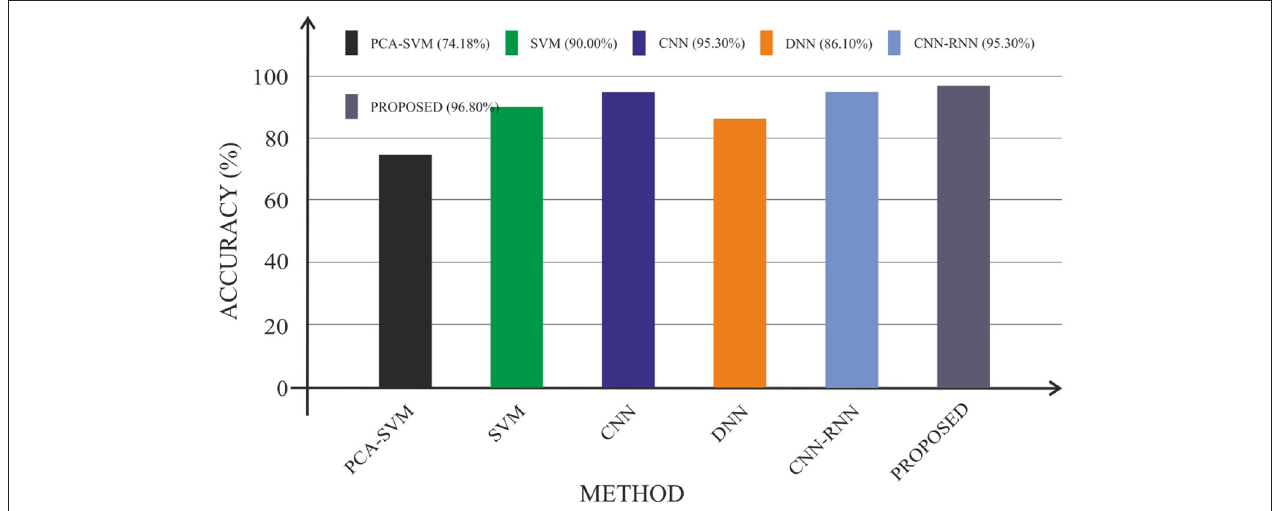
FIGURE 11 | Performance comparisons in terms of